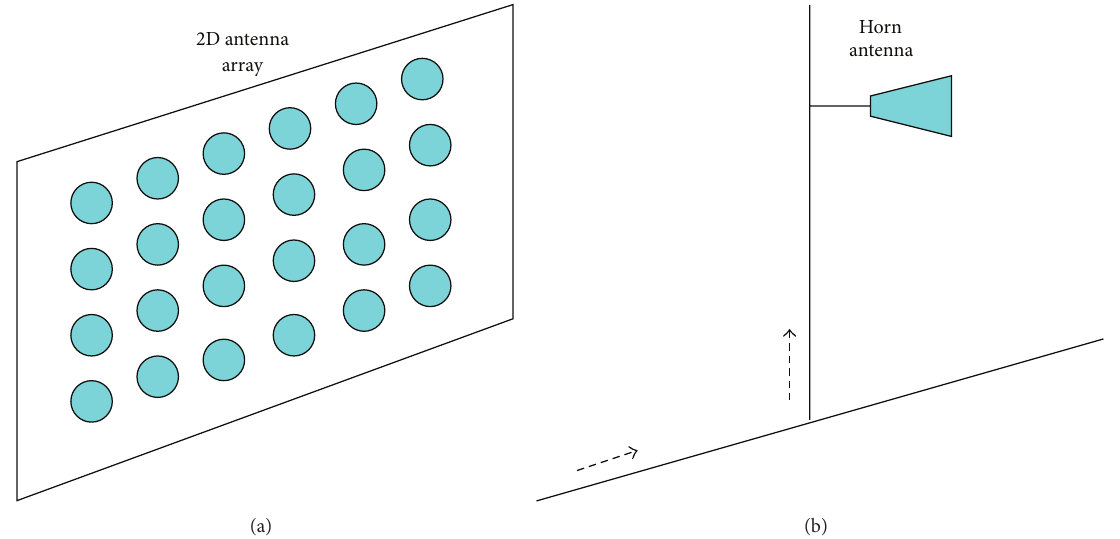
Figure 4: 3D EM imaging technical solutions: on the right, single antenna on a 2-axis translator; on the left, a fixed 2D antenna array.